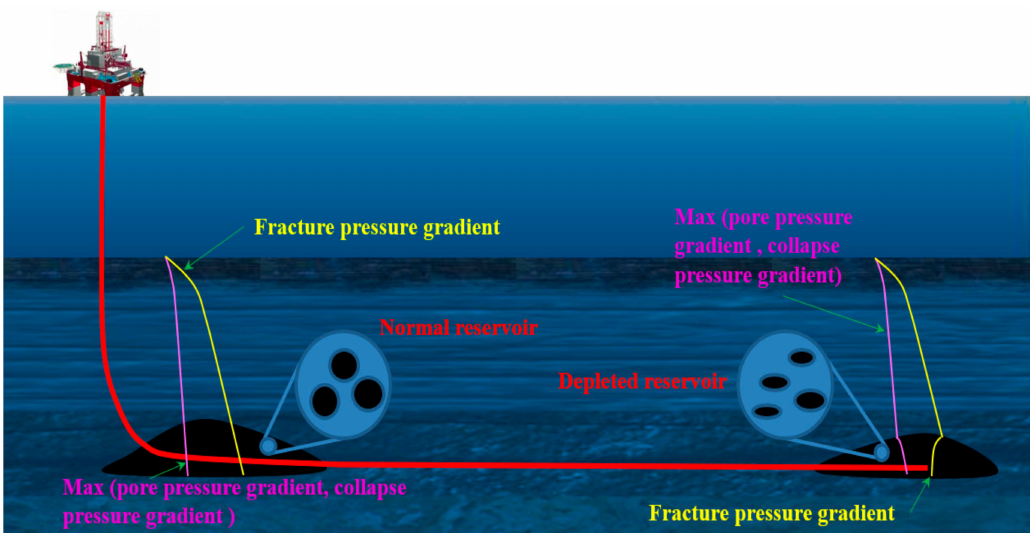
Figure 2. Schematic of extended-reach drilling targeting offshore depleted